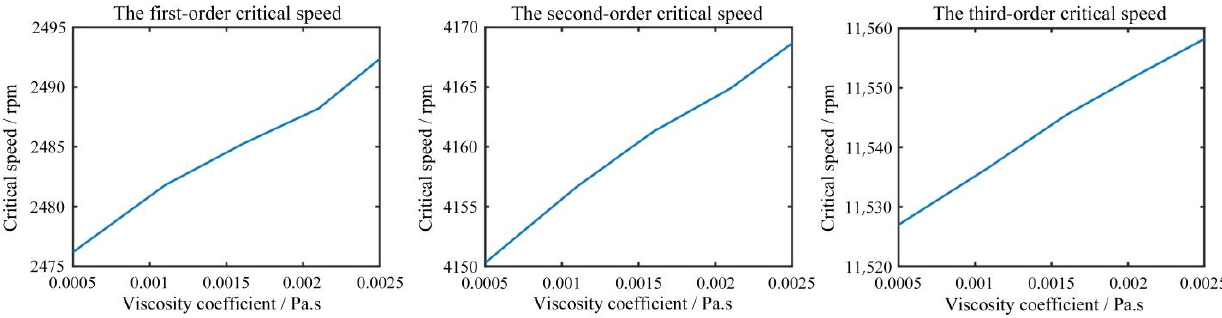
Figure 13. Influences of the ratio of length to diameter λ on the first three critical speeds.